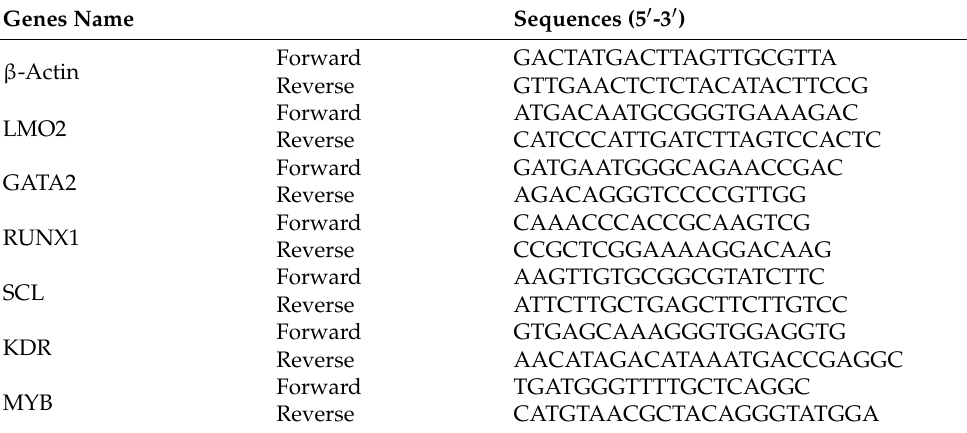
Table 3. List of primers for real-time